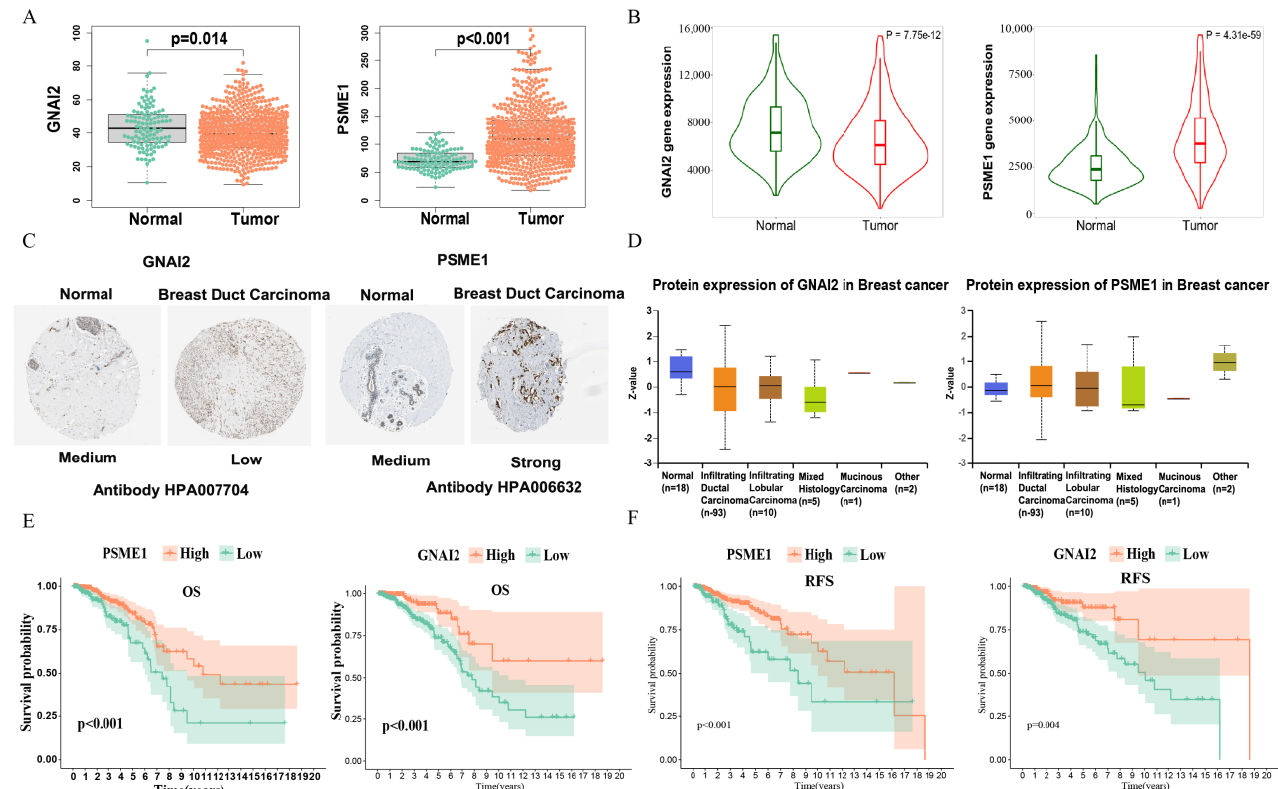
Figure 9. Risk model gene expression and prognostic characteristics: ( A ) Differential expression of risk model gene between tumor tissues and normal tissues in TCGA. ( B ) Differential expression of risk model gene between tumor tissues and normal tissues in TNMplot platform, which contains multiple database transcriptome data. ( C ) Differences in protein expression of the risk model gene in tumor tissue and normal tissue from Human Protein Atlas immunohistochemistry. ( D ) Differences in protein expression of the risk model gene in tumor tissue and normal tissue from the UALCAN platform. ( E ) Kaplan–Meier overall survival curves for patients in high − and low − expression groups of risk model gene of the TCGA cohort. ( F ) Kaplan–Meier relapse − free survival curves for patients in high − and low − expression groups of risk model gene of the GEO